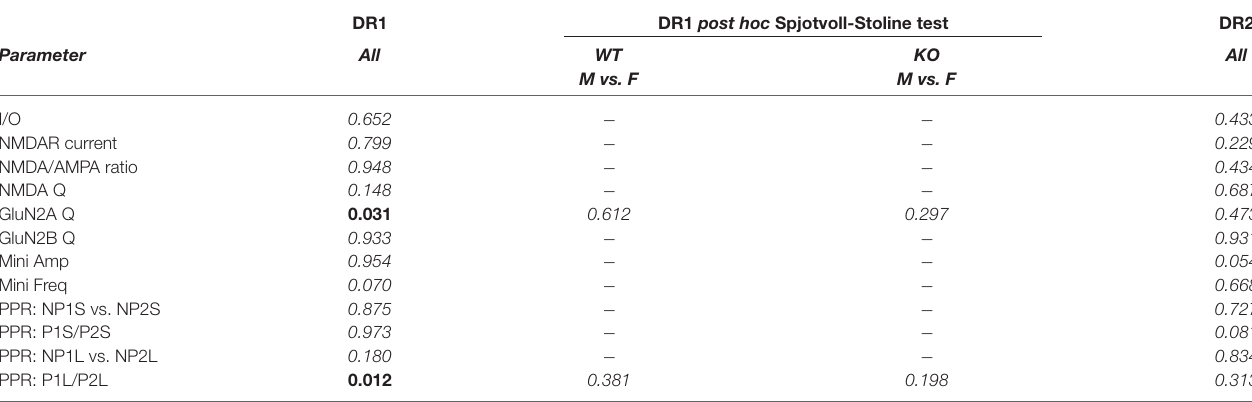
TABLE 2 | Probability summary of main effect of sex on NL1KO